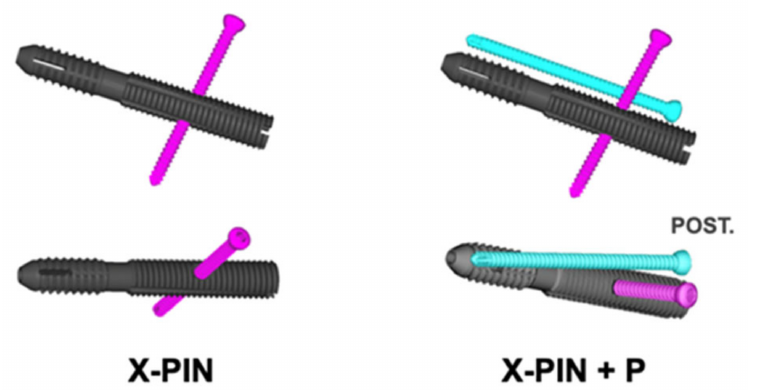
Figure 2. Representation of the X-PIN (left side) and the X-PIN+P. Observe that both extremities of the main screw have threads of different pitches and areas, allowing compression between the fractured fragments. A 4.7 mm locking screw (represented in pink) crosses the main screw from superior to inferior through a smooth hole and anchors bicortically. In the X-PIN+P model, a third screw (a fully threaded 4.7 mm screw, represented in blue) acts as a position screw from posterior to anterior along the femoral neck, transfixing the fracture without a sliding